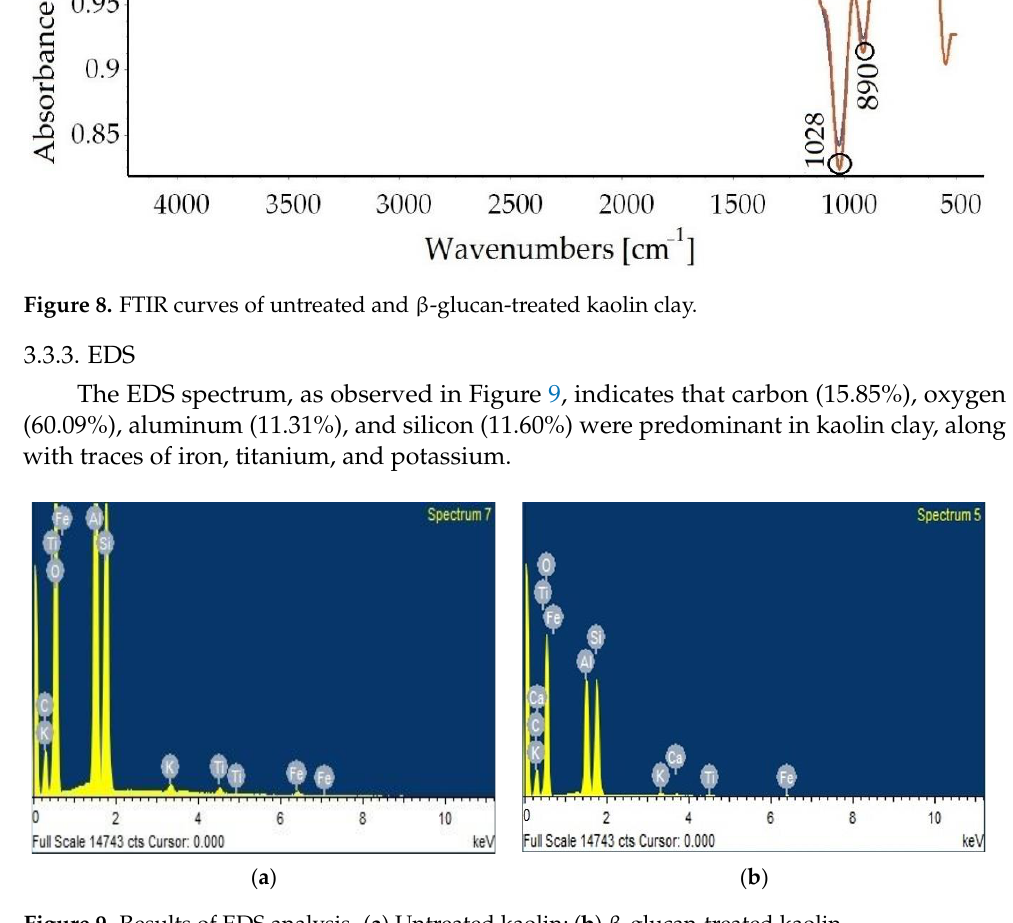
Figure 10. Particle size analysis of untreated and β -glucan-treated kaolin. An increase in particle size of the β -glucan-treated clay is an indicator of cementitious aggregation during the first 28 days of curing. This chemical reaction facilitated the blend- ing of kaolin clay and β -glucan, which resulted in the filling of voids and establishment of connecting bridges within the soil as well as external coating on the surface of the treated clay. Application of heat and establishment of chemical bonds improve the adhe- sion of the kaolin clay particles, which results in increased stiffness and improved CBR.